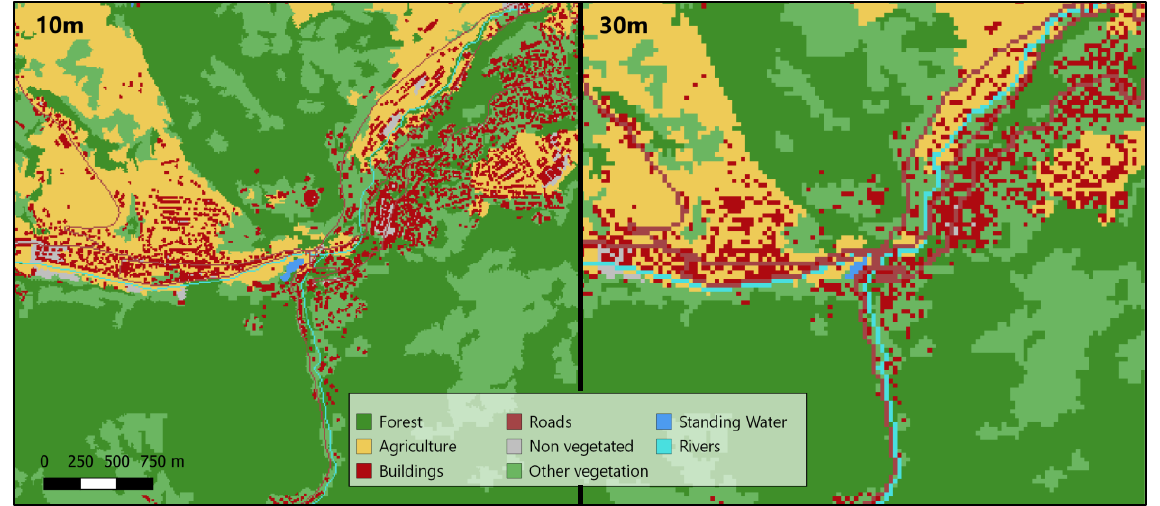
Figure 15. Comparison of the 10 and 30 m LULC map product for 2019. The Sentinel-2-based (10 m) product on the left and